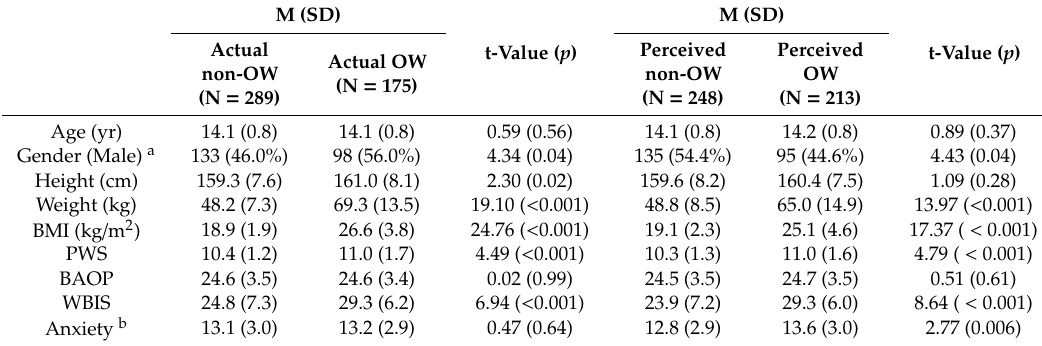
Table 1. Participant characteristics (N =